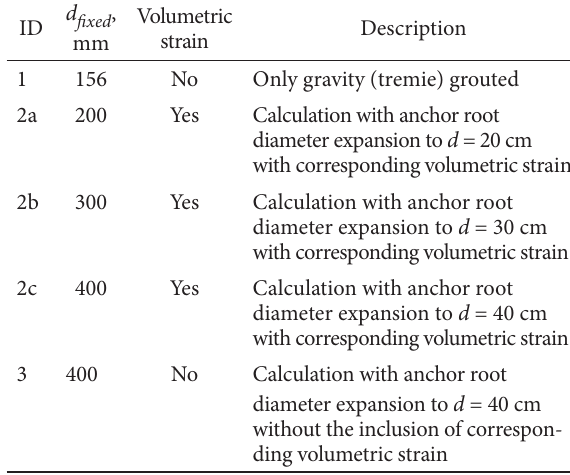
Table 8. Methodology of the performed analysis